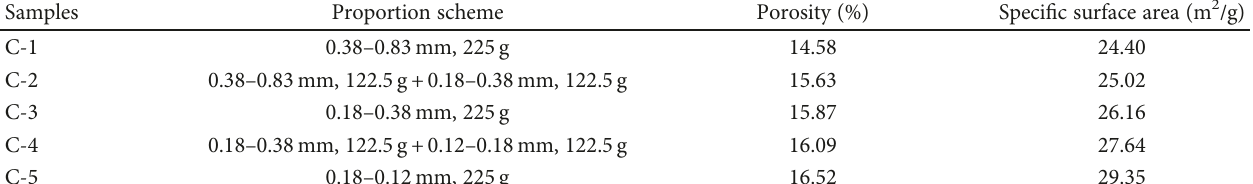
Table 1: Proportion scheme and pore structure of coal samples used in the experiments.